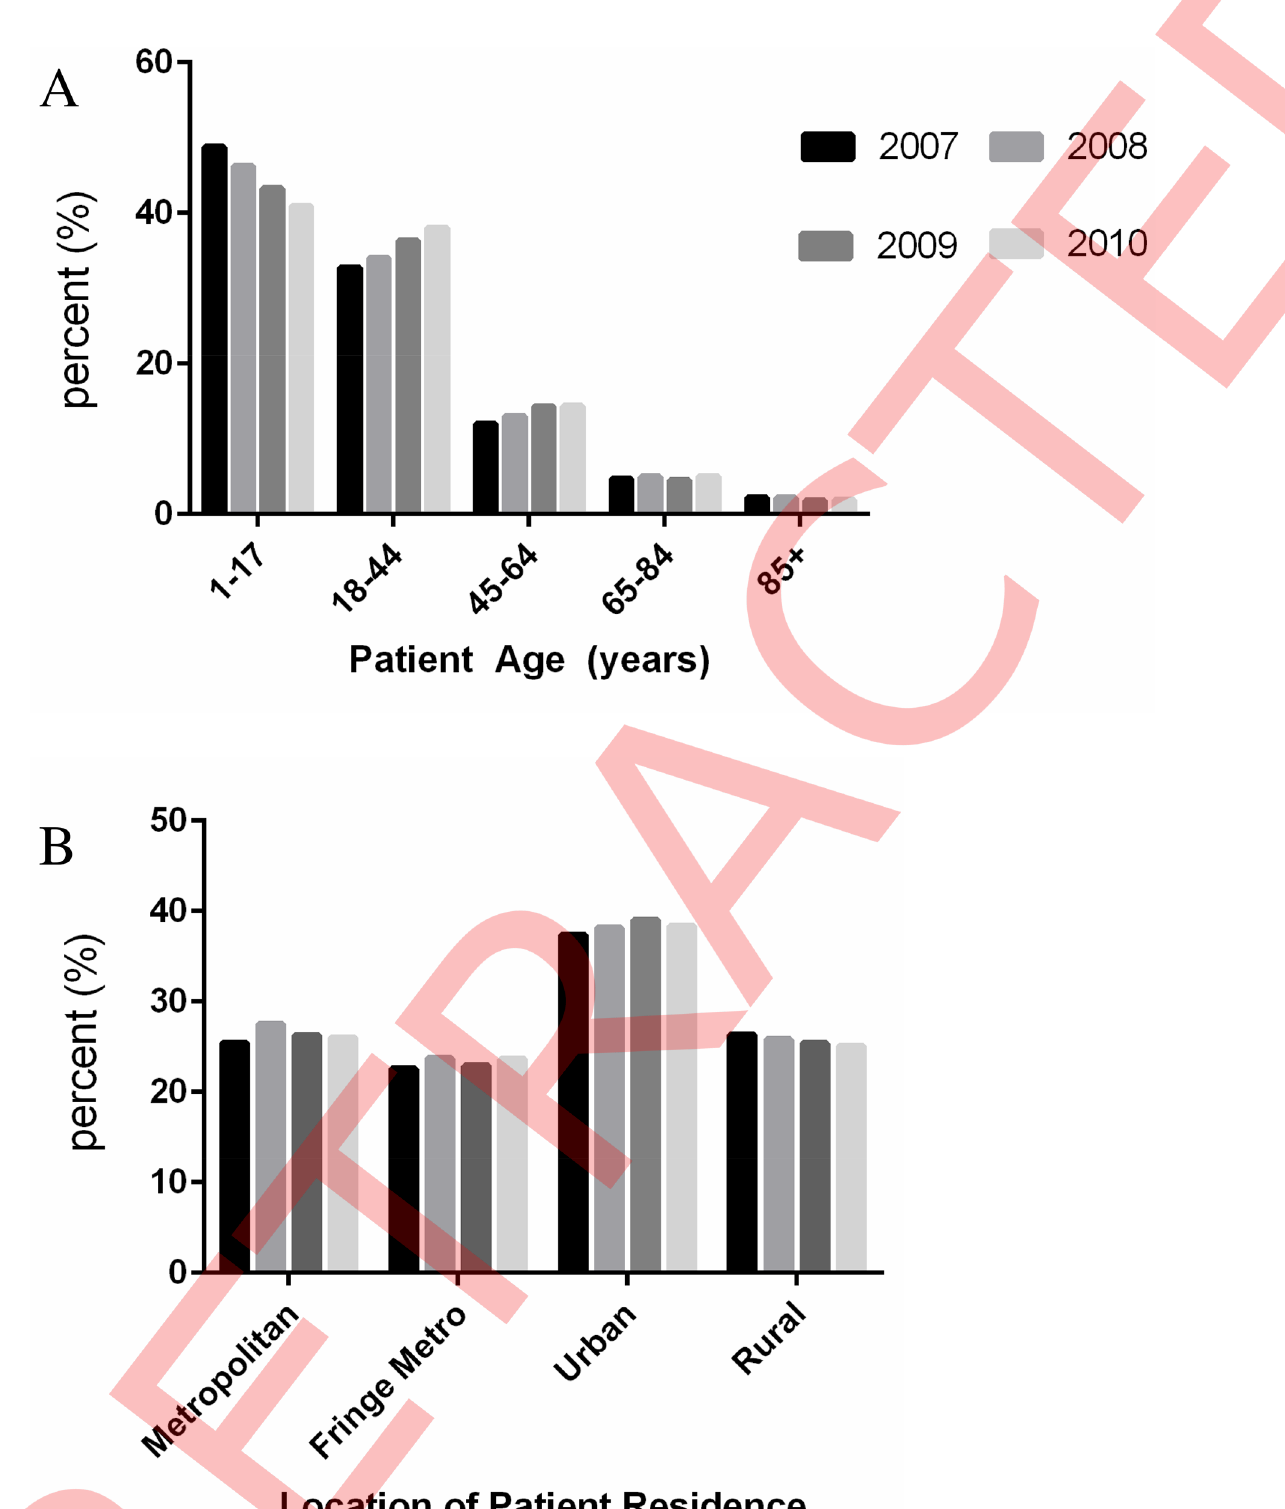
Fig 4. The breakdown of hospital discharges for attention-deficit, conduct, and disruptive behavior (CCS diagnostic category – 652) by (A) patient age and (B) location of patient residence. Data are presented as the average percent for available HCUPNET reporting states for each year indicated and may therefore not add to 100%. Masked data ( * ) in HCUPNET, or data for which there were 10 or fewer patient discharges or fewer than 2 hospitals, were excluded from analysis. The state of Hawaii is excluded from the descriptive statistics reported for the ADHD population.